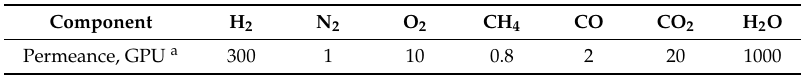
Table 4. Permeances of the gas separation